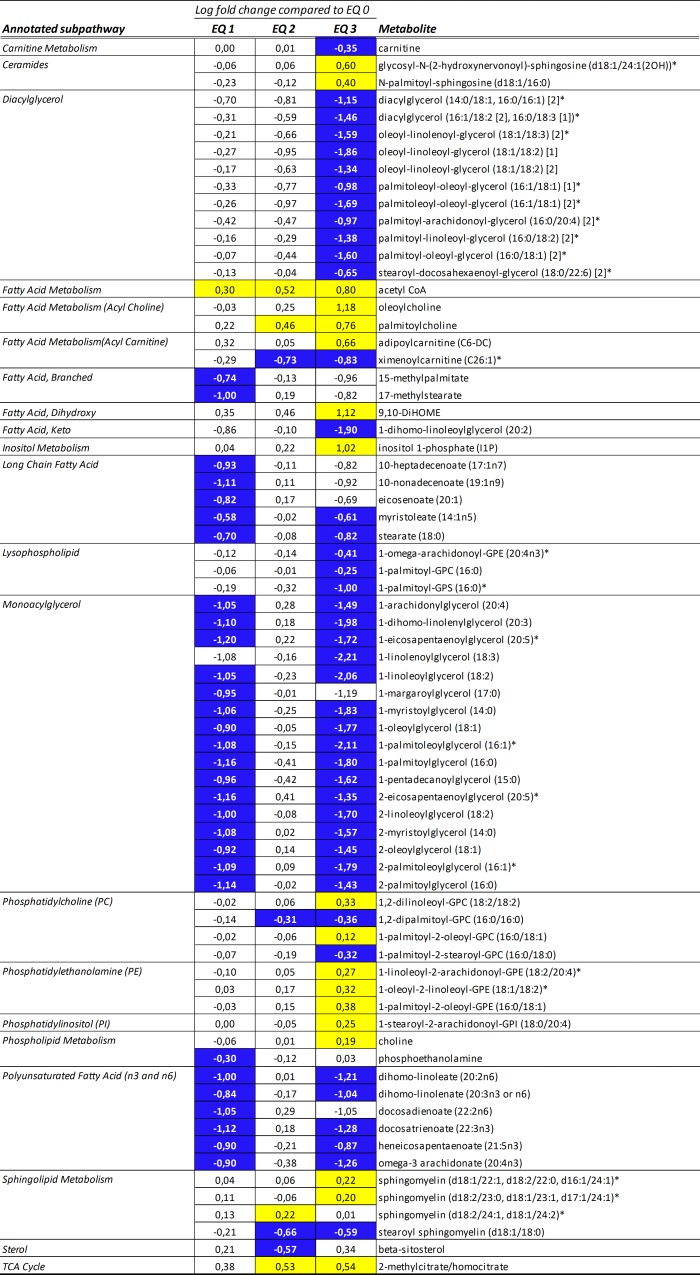
Heat map of significantly altered metabolites (ANOVA, p<0.05) belonging to the “lipid” super pathway in livers of Atlantic salmon (Salmo salar L.) exposed to graded levels of ethoxyquin (EQ) through their diet for 90 days.Scaled intensity means were used to calculate log2 fold changes in the individual exposure groups compared to unexposed control animals (EQ 0). Significance of change was analyzed through pairwise comparisons between the individual exposure groups and the control, with colors denoting a significantly increased (yellow) or decreased (blue) levels compared to the control. See S4 Table for a complete overview of individual metabolites.